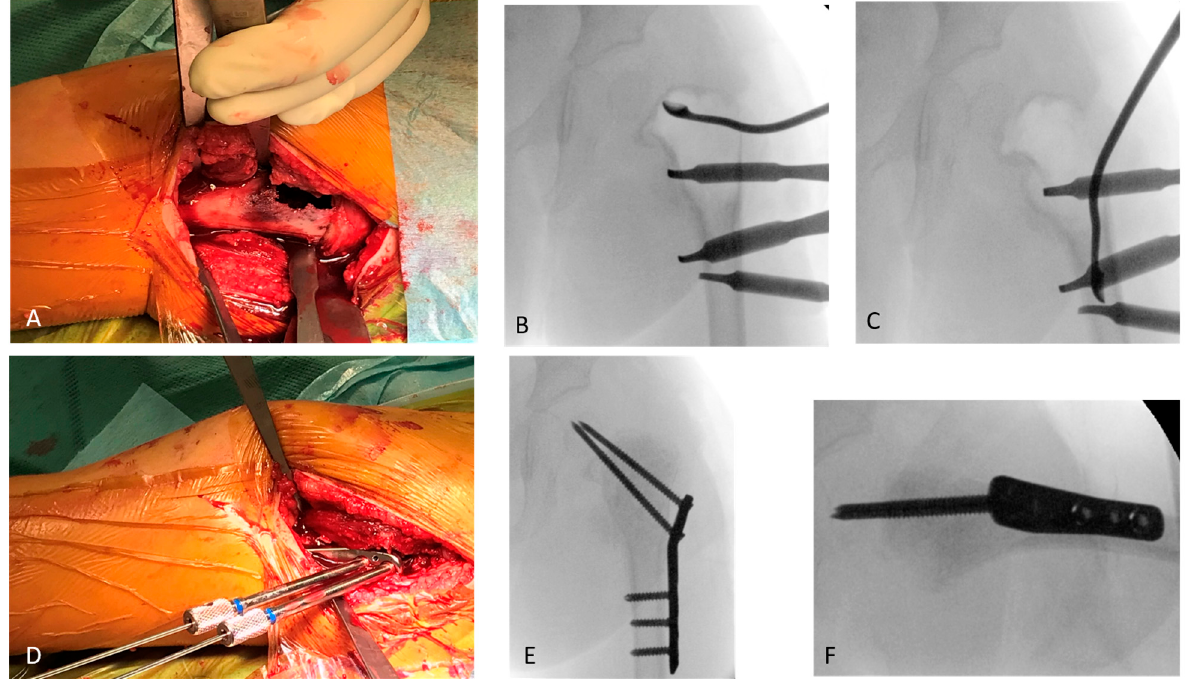
Figure 2. The femur is reached via a lateral approach. The cyst has already perforated the ventral cortex ( A ). The cyst is excochleated with a flexible sharp curette, which is documented with the image intensifier ( B , C ). After exclusion of malignancy in the frozen section and subsequent excochleation, rinsing with polidocanol and filling of the cyst with allogen spongiosa an osteosynthetic stabilisation is performed ( D ). After completion of the osteosynthesis, the X-ray control is carried out in two planes ( E , F ), showing the correct central position of the transphyseal screws in the epiphysis.